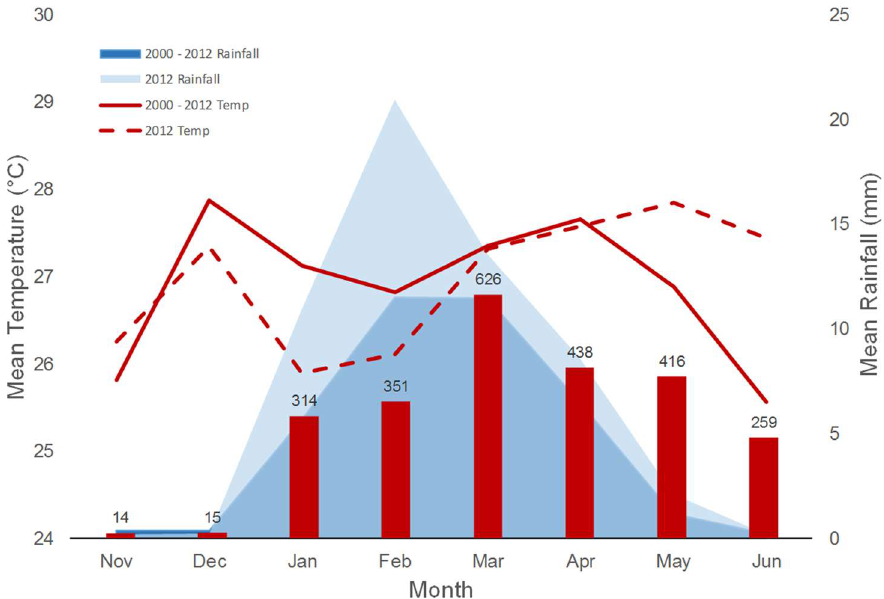
Figure 2. The study site, Guayaquil, is located within Guayas province in coastal Ecuador. ( Panel A ) shows the location of Ecuador (medium green) in S. America (bright green); ( Panel B ) shows the location of Guayaquil (dark orange) within Guayas Province (warm yellow), in Ecuador; ( Panel C ) shows the city of Guayaquil, detailing the census block structural layout, and showing where major and minor waterways exist surrounding the city limits.